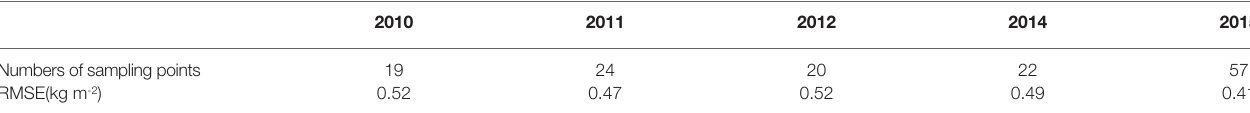
TABLE 6 | Validation accuracy for AGB inversion in 2010,2011,2012,2014 and